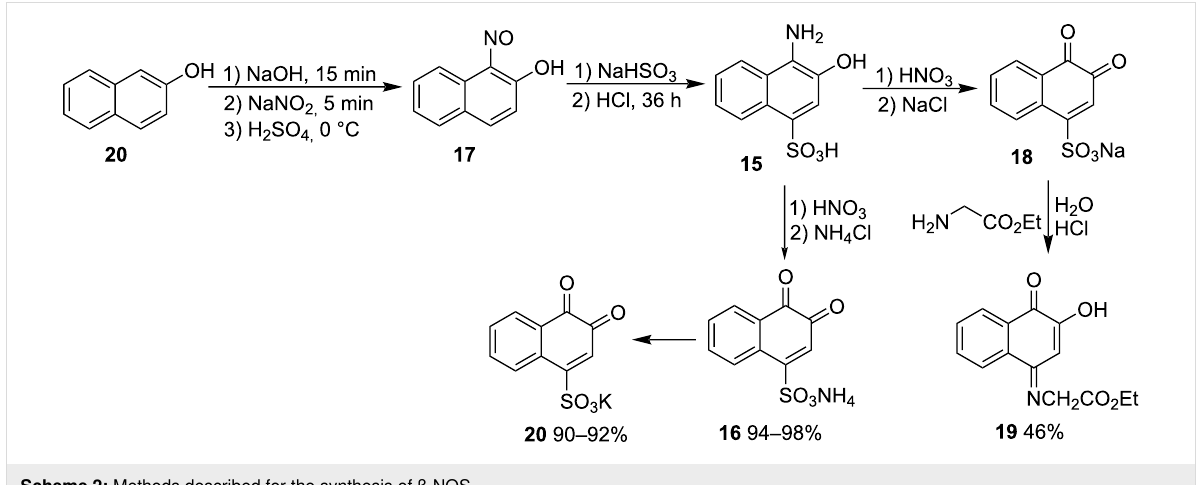
Scheme 2: Methods described for the synthesis of β